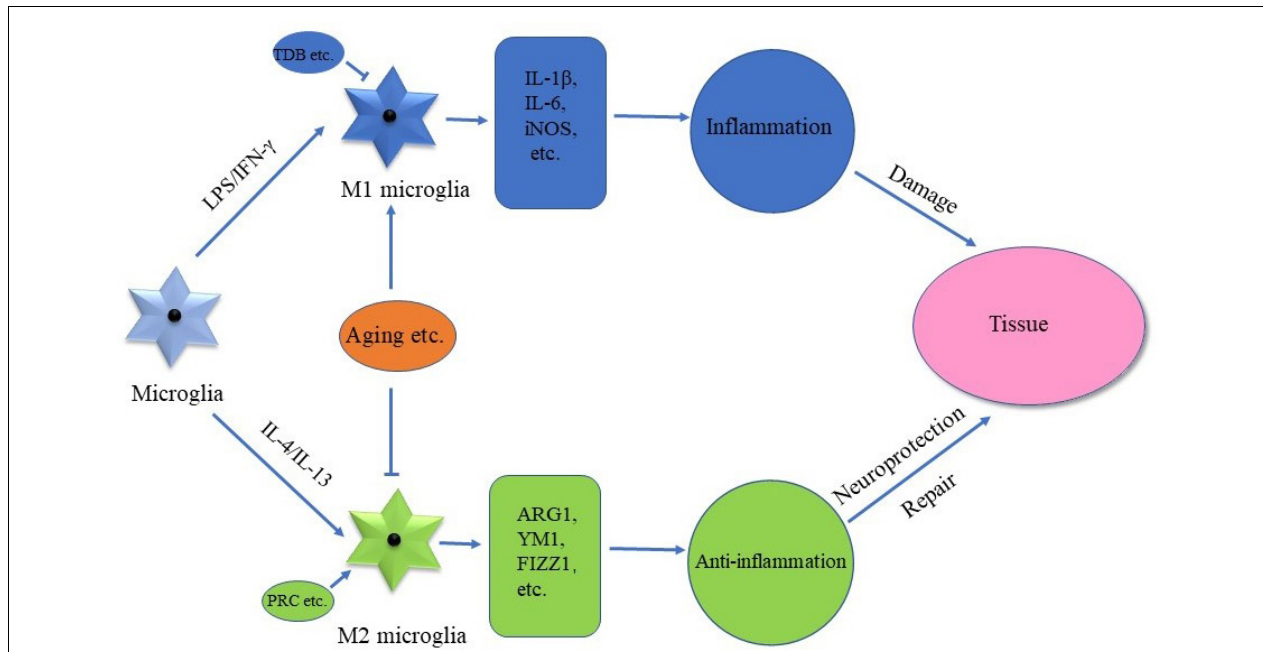
FIGURE 1 | A paradigm of M1 and M2 phenotypes of microglial cells. Microglia activation is categorized into two phenotypes, namely, M1 phenotype and M2 phenotype. M1 microglia could be induced by lipopolysaccharide/interferon- γ (LPS/IFN- γ ), leading to the increase of pro-inflammatory factors. M2 microglia could be induced by IL-4/IL-13, which leads to the increase of anti-inflammatory factors. Thus, M1 microglia contribute to the inflammatory response, while M2 microglia contribute to the neuroprotection and repair processes of